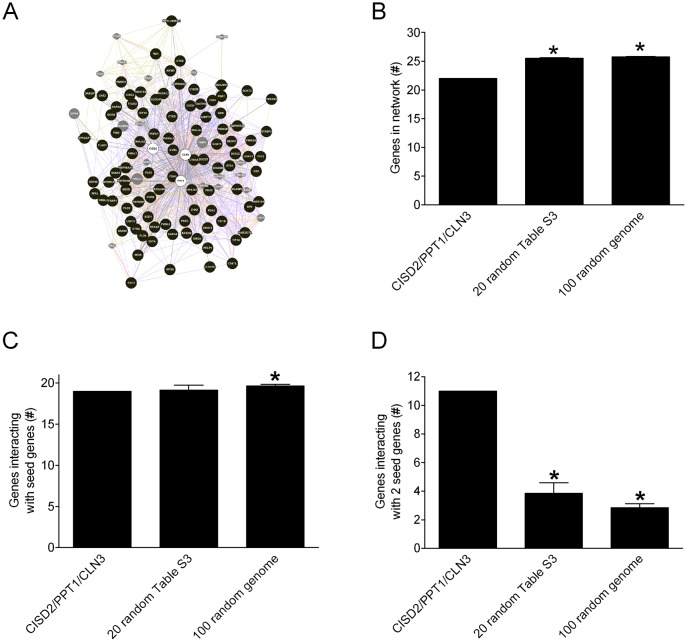
The CISD2/PPT1/CLN3 multi-species interaction network.(A) GeneMania network depiction using human gene symbols. Seed genes (CISD2, PPT1 and CLN3) are indicated by open circles. Filled circles represent genes predicted to interact with seed genes. Smaller grey circles represent genes predicted by GeneMania to also be in the network. Lines represent GeneMania interactions between genes. Total number of genes (B), number of genes that interact with at least one seed gene (C) and the number of genes that interact with two seed genes (D) in the CISD2/PPT1/CLN3 network, for 20 randomly chosen sets of three seed genes from supplementary material Table S3 and 100 randomly chosen sets of three genes from the human genome. The total number of genes was significantly greater in the randomly seeded networks (panel B, one-sample t test, p<0.0001). The number of network genes that interacted with at least one seed gene was comparable in all networks (panel C, individual Fisher's exact tests, n.s.), but the number of genes that interacted with two seed genes was significantly higher in the CISD2/PPT1/CLN3 network (*individual Fisher's exact tests; 20 networks from supplementary material Table S3, p = 0.017; 100 networks from human genome, p = 0.0051).